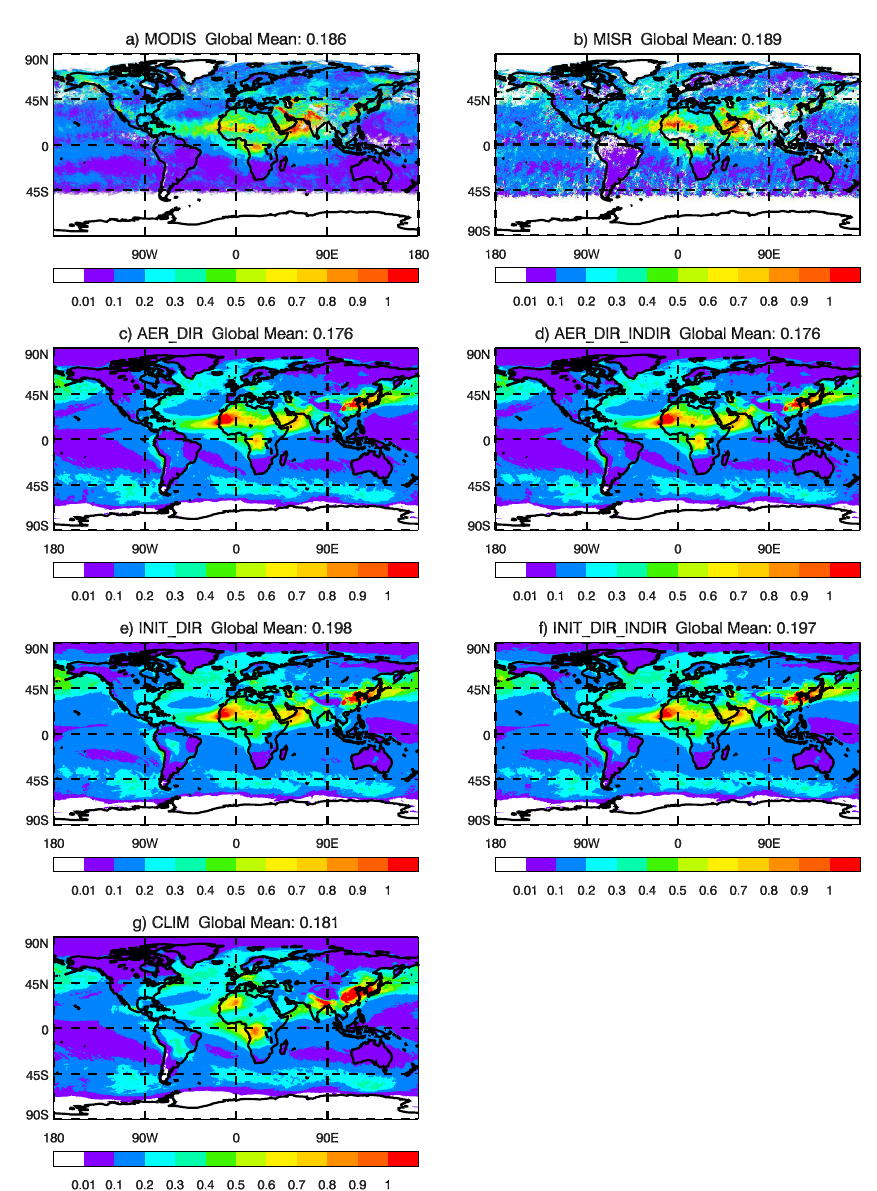
Fig. 2. Comparison of model AOD (550nm) at T + 120 (day 5) with satellite observations from 24 June to 24 July 2009: (a) MODIS observations, (b) MISR observations, (c) AER DIR, (d) AER DIR INDIR, (e) INIT DIR, (f) INIT DIR INDIR and (g) CLIM.